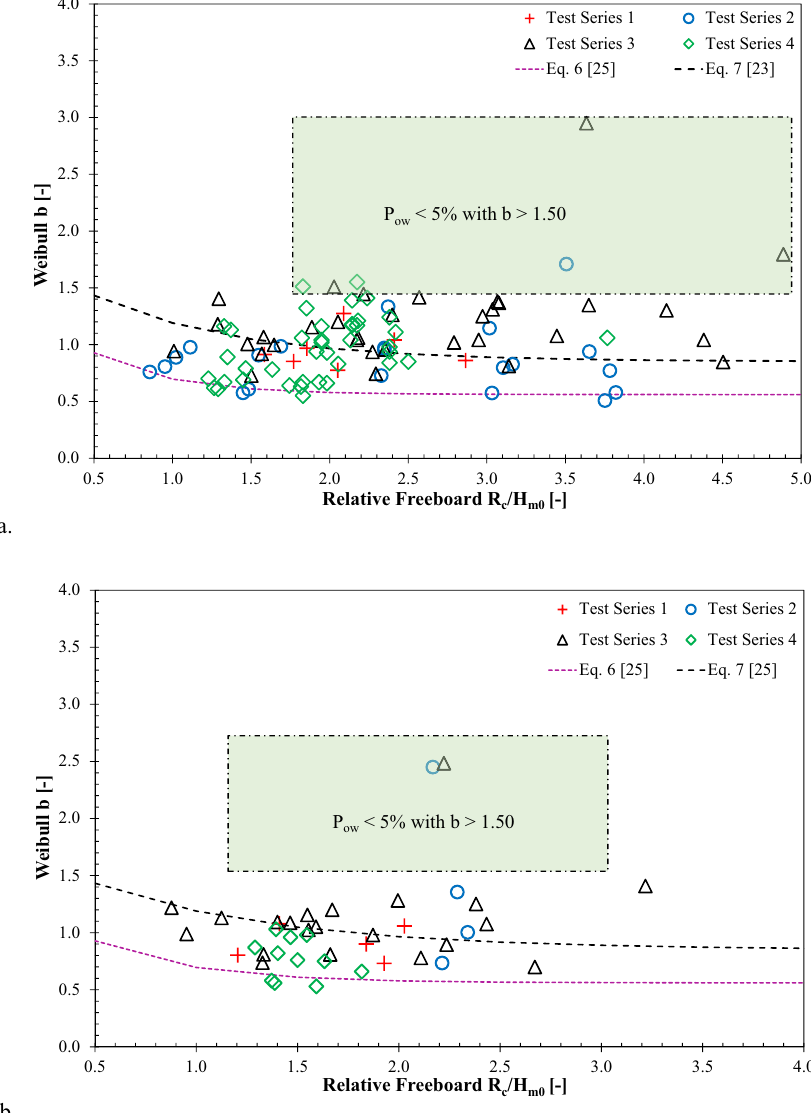
Figure 8. Influence of relative crest freeboard on Weibull b parameters: (a) impulsive wave conditions and (b) non-impulsive wave